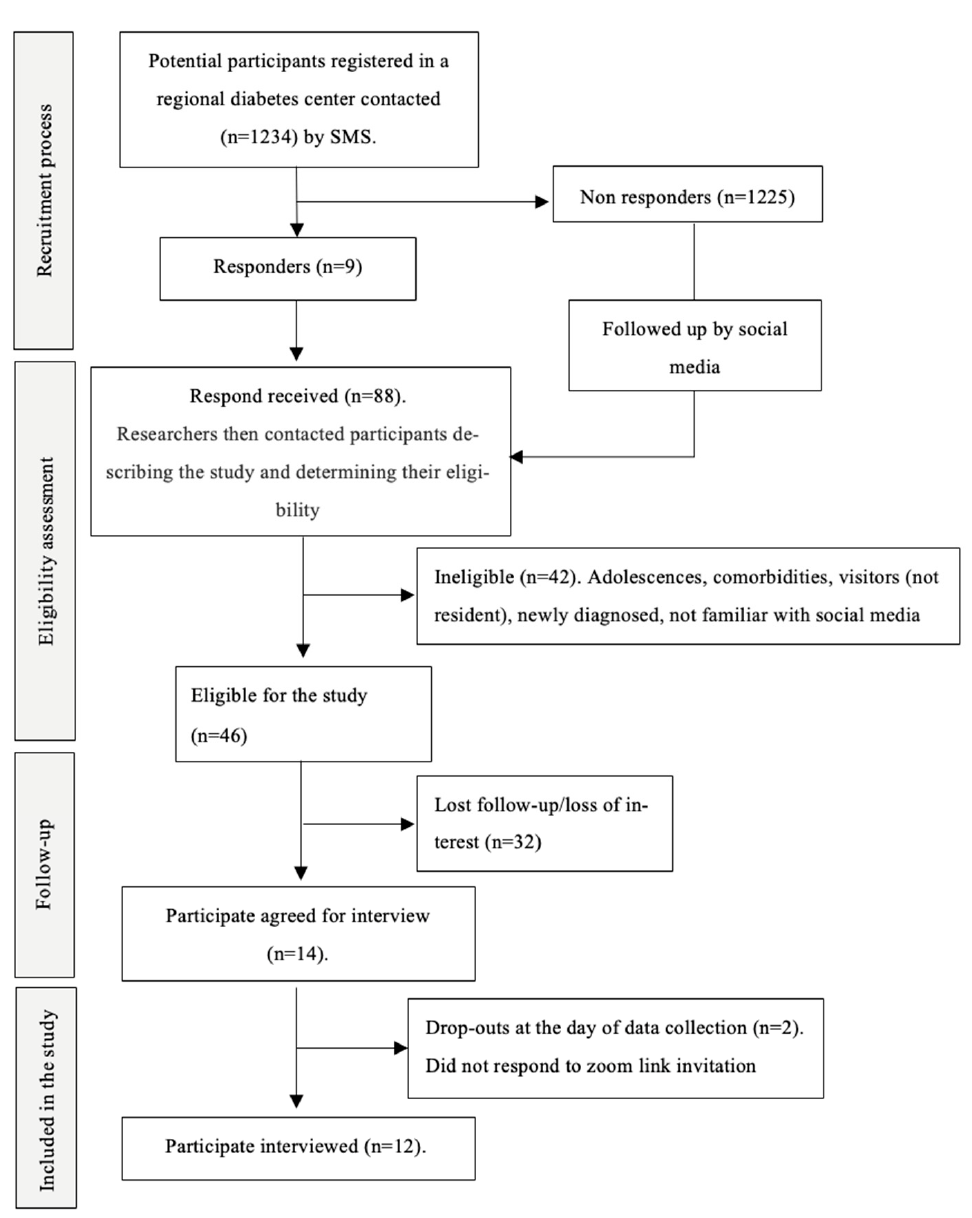
Figure A1. Recruitment